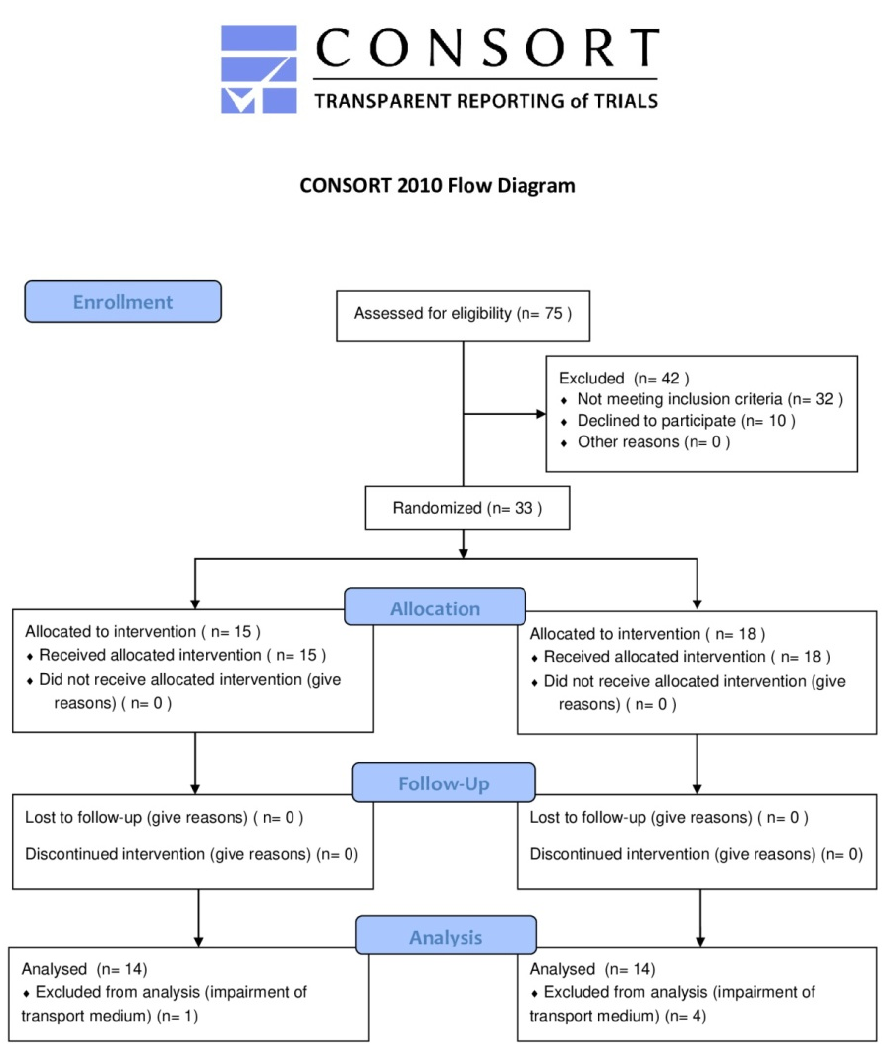
Figure 1. CONSORT flow diagram.